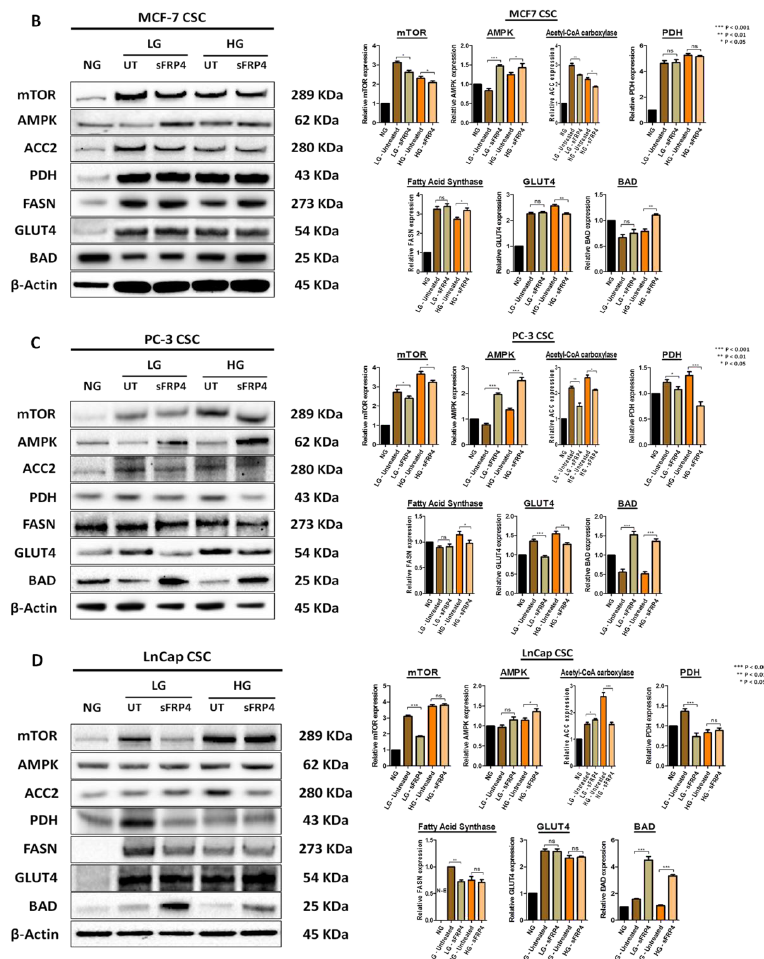
Figure 7. The effect of sFRP4 on CSC metabolism target proteins: Changes in CSC metabolic profile and the post-translational modifications with increasing glucose conditions. ( A ) MDA231 CSCs; ( B ) MCF7 CSCs; ( C ) PC-3 CSCs; and ( D ) LnCap CSCs were treated with sFRP4 for 24 h. Densitometry analysis was performed using ANOVA for analysis variance with Bonferroni test for comparison showing significance as *** p < 0.001; ** p < 0.01; * p < 0.05; ns —non-significant. Blots and relative protein expressions are mean ± standard error of mean from three independent